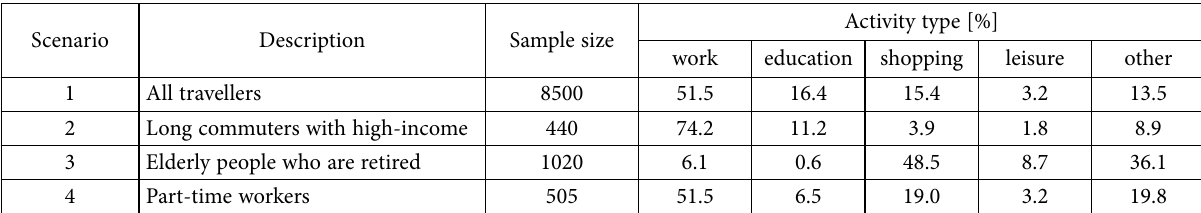
Table 1. The sample size and the characteristics of the four scenarios *